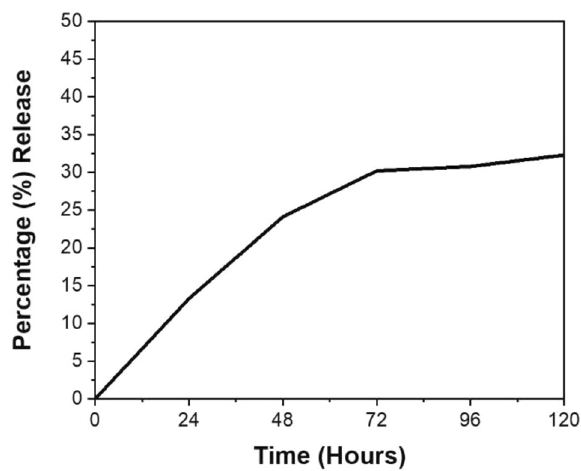
Fig. 4 Release kinetics of coumarin-6 from PLGA55 nanoparticles